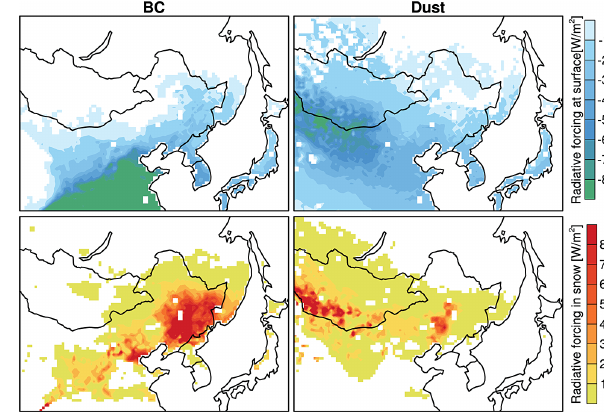
Figure 12. Absorption enhancement ratio of BC (0.1µm effective radius) internally mixed with snow grains at the five spectral wave- bands as a function of snow grain effective radius.